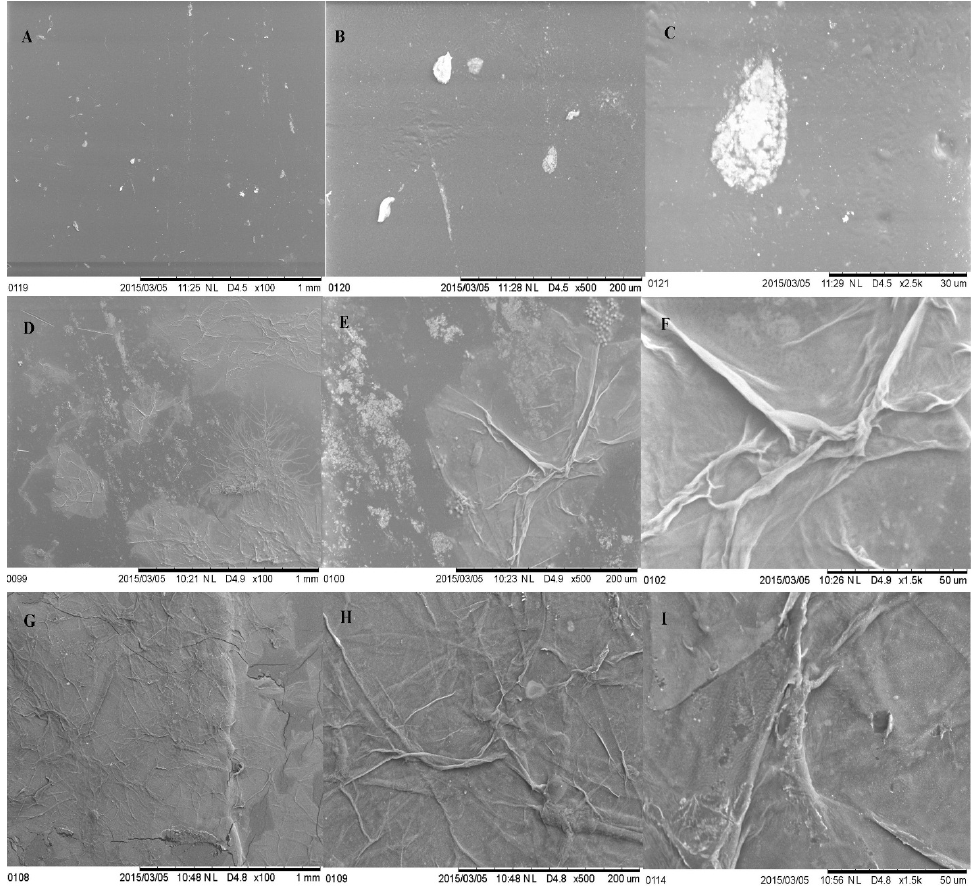
Figure 7. Representative SEM micrographs of pristine and Aloe vera dip ‐ coated mPE ‐ nHA. ( A ) Pristine mPE ‐ nHA at 100×; ( B ) mPE ‐ nHA at 500×; ( C ) mPE ‐ nHA at 2500×; ( D ) 12 h Aloe vera dip ‐ coated mPE ‐ nHA at 100×; ( E ) 12 h Aloe vera dip ‐ coated mPE ‐ nHA at 500×; ( F ) 12 h Aloe vera dip ‐ coated mPE ‐ nHA at 1500×; ( G ) 24 h Aloe vera dip ‐ coated mPE ‐ nHA at 100×; ( H ) 24 h Aloe vera dip ‐ coated mPE ‐ nHA at 500×; ( I ) 24 h Aloe vera dip ‐ coated mPE ‐ nHA at 1500×.